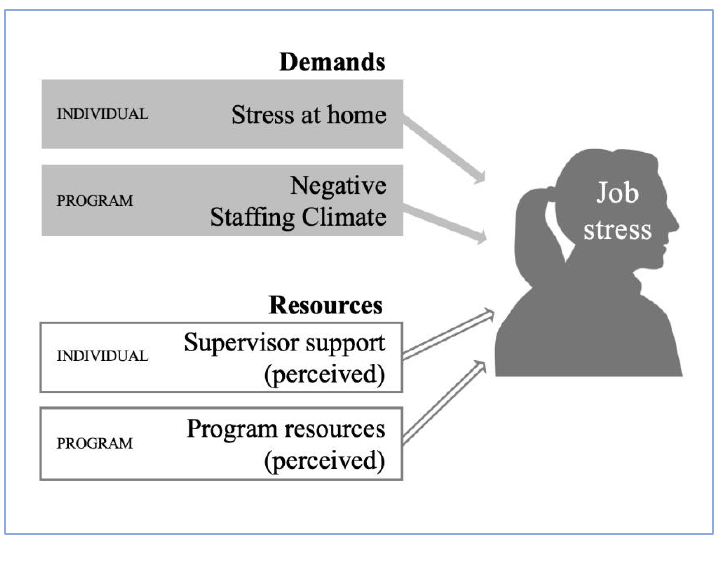
Figure 1. Program and Individual Demands and